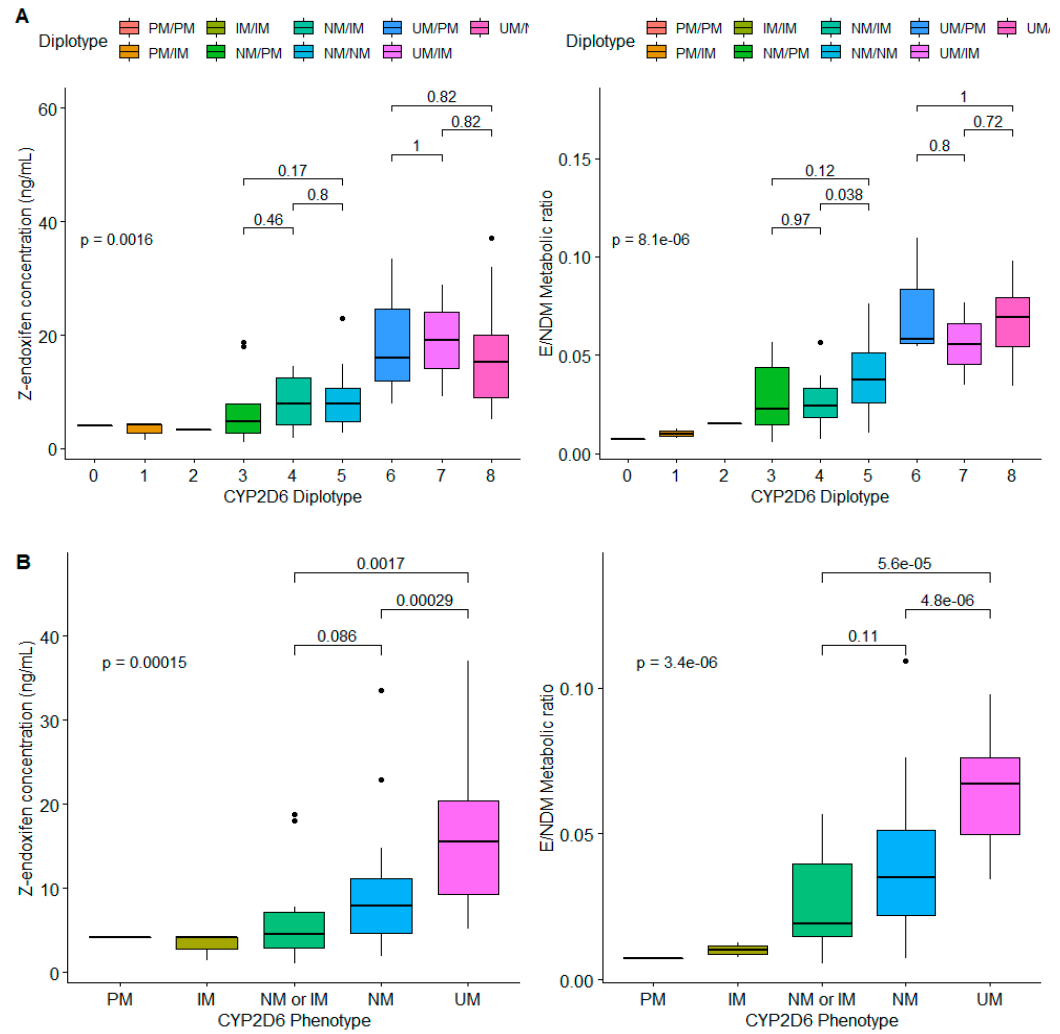
Figure 2. Plasma concentration of endoxifen and metabolic ratio (MR E / NDM ) by CYP2D6 diplotype ( A ) and phenotype ( B ).